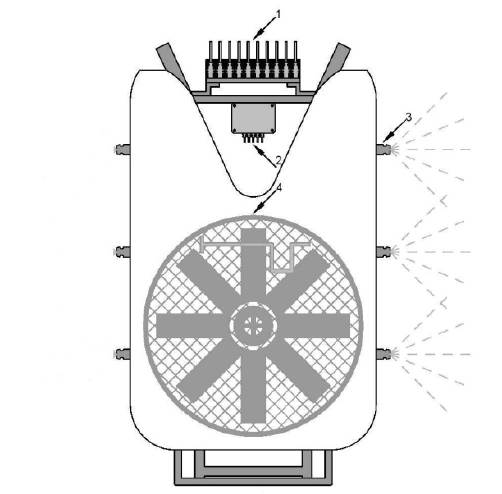
Figure 8. A prototype mounted air-assisted sprayer: (1) electro-magnetic